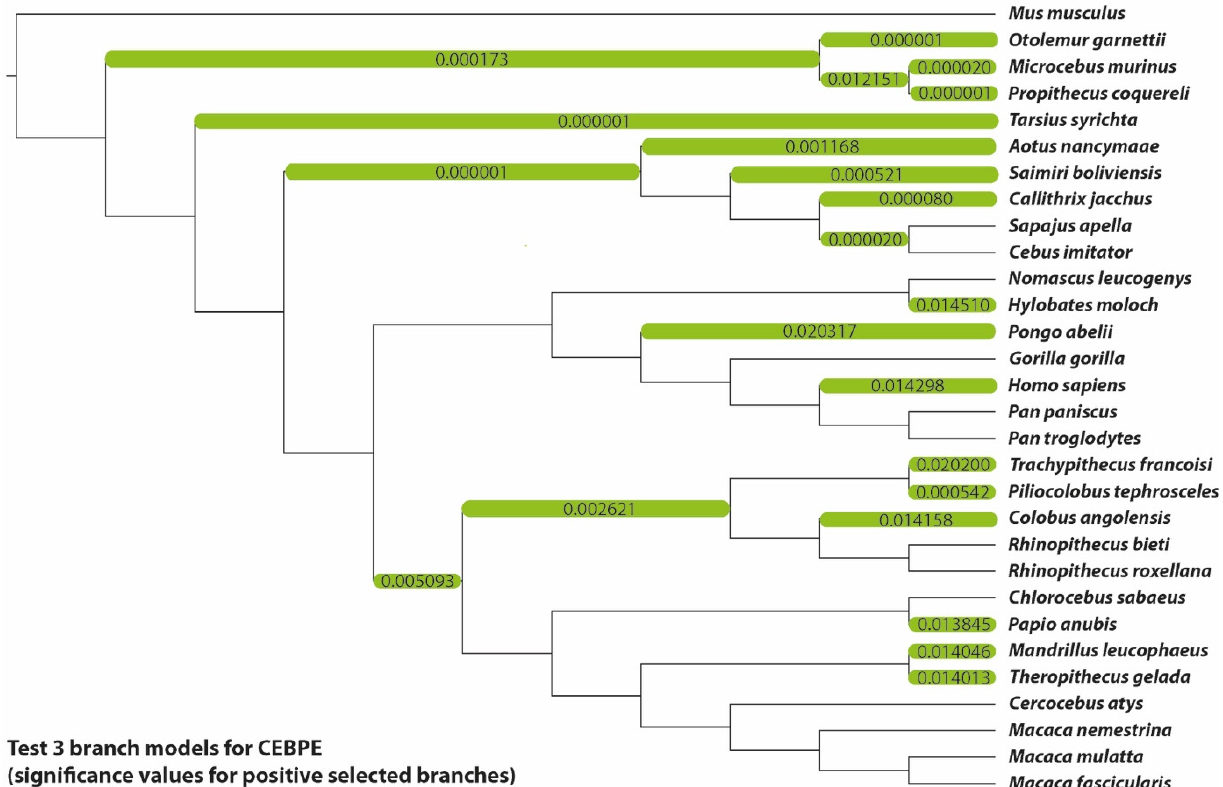
Figure 5. Phylogenetic tree of the CEBPE dataset. Branches significantly under positive selection according to the branch models are marked green (corresponding to Figure 2) and labelled with the p -values inferred by their respective model comparisons.